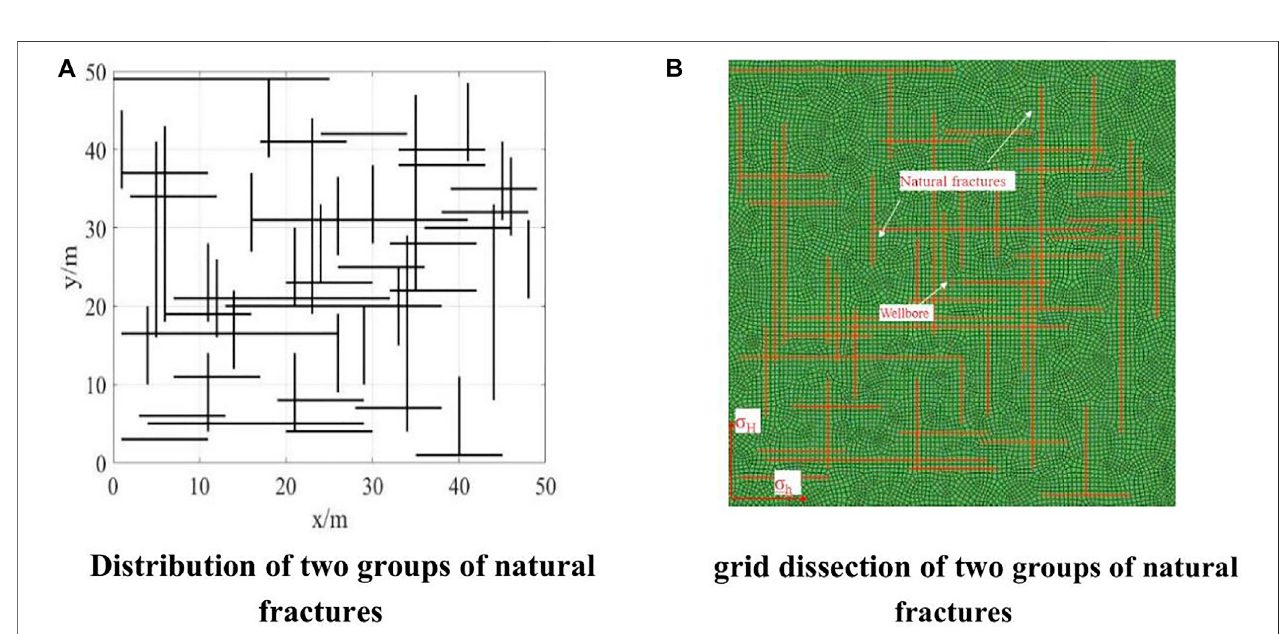
FIGURE 4 | The natural fracture distribution and grid dissection. (A) Distribution of two groups of natural fractures. (B) grid dissection of two groups of natural fractures.